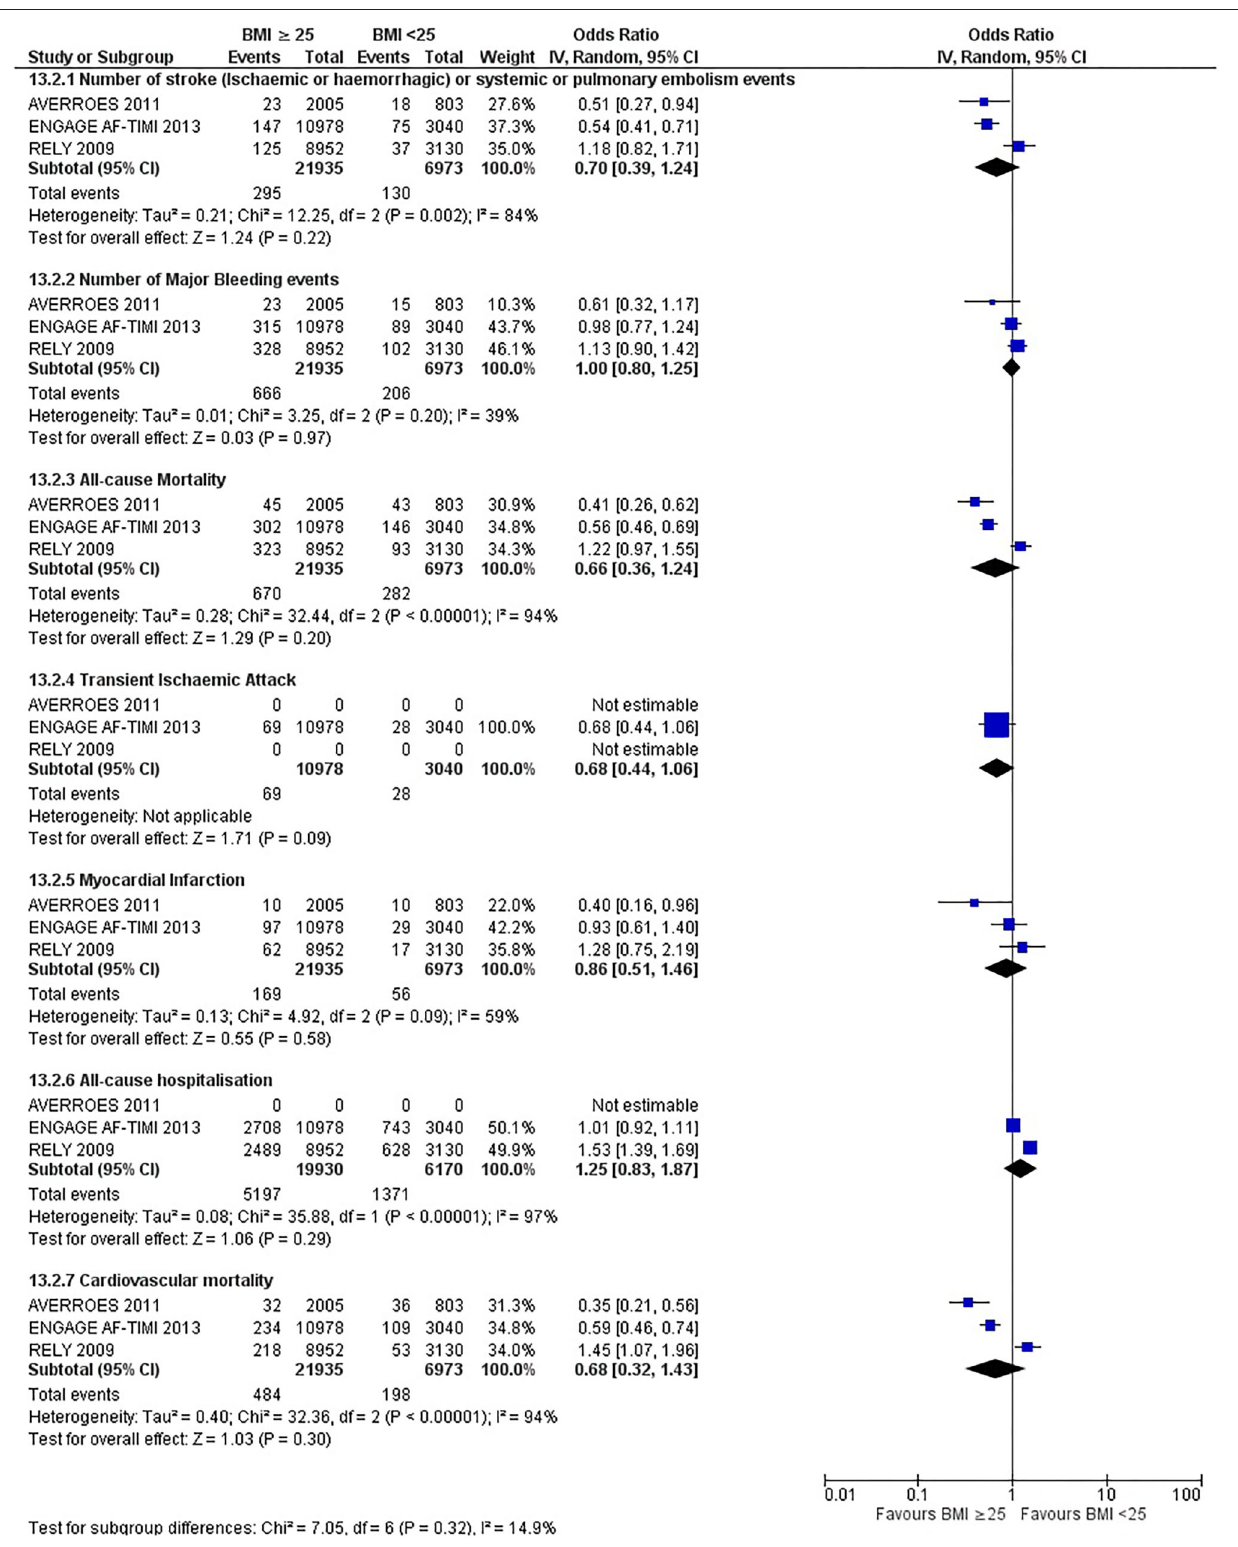
Frontiers in Cardiovascular Medicine |